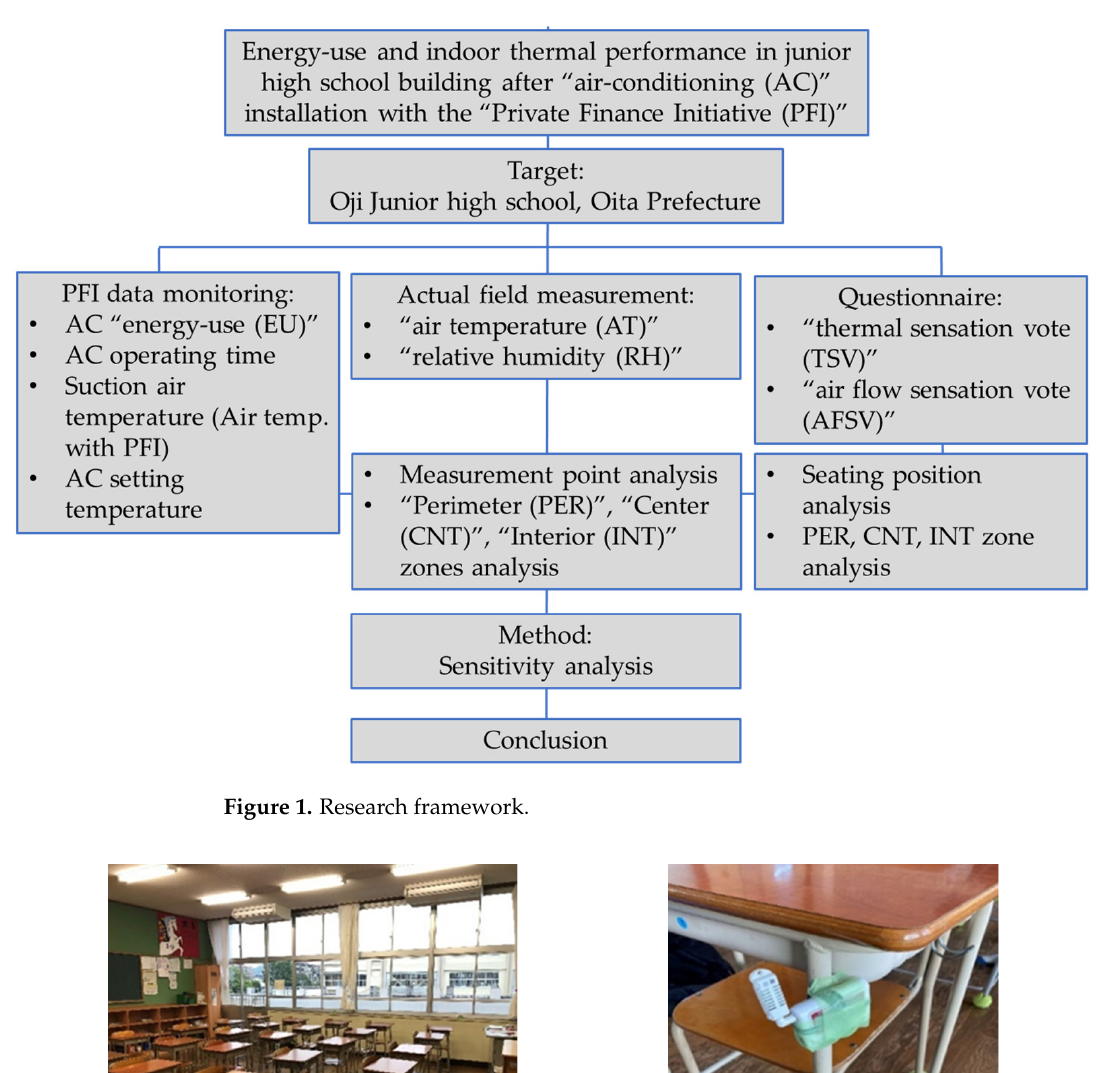
Figure 2. Field measurement condition ( a ) Inside a typical classroom of Oji Oita Junior High School and ( b ) the position of the measurement item, TR-72NW.